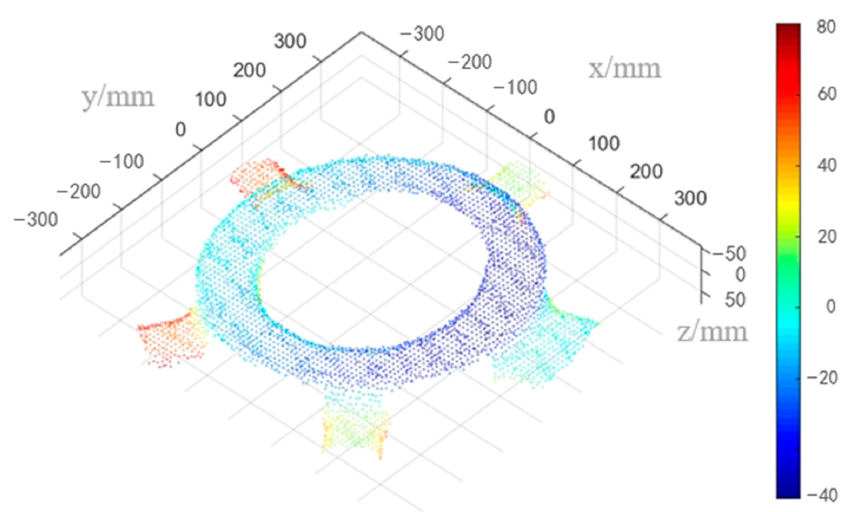
Figure 9. FPFH calculation schematic diagram.